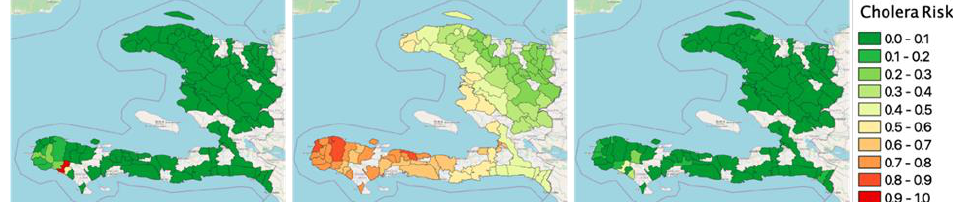
Figure 6. Commune-level cholera risk ground truth ( left ), existing model output ( middle ), and ML model prediction ( right ) for October.